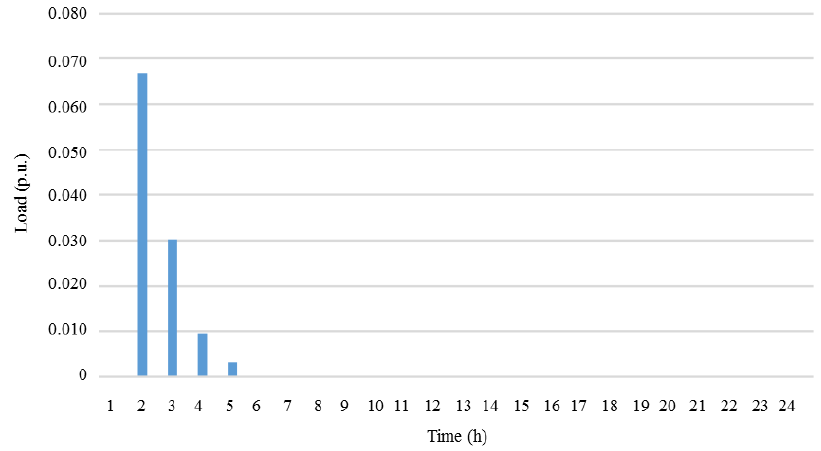
Figure 14. Load demand profile for Case 5 (15 EVs, controlled charging).